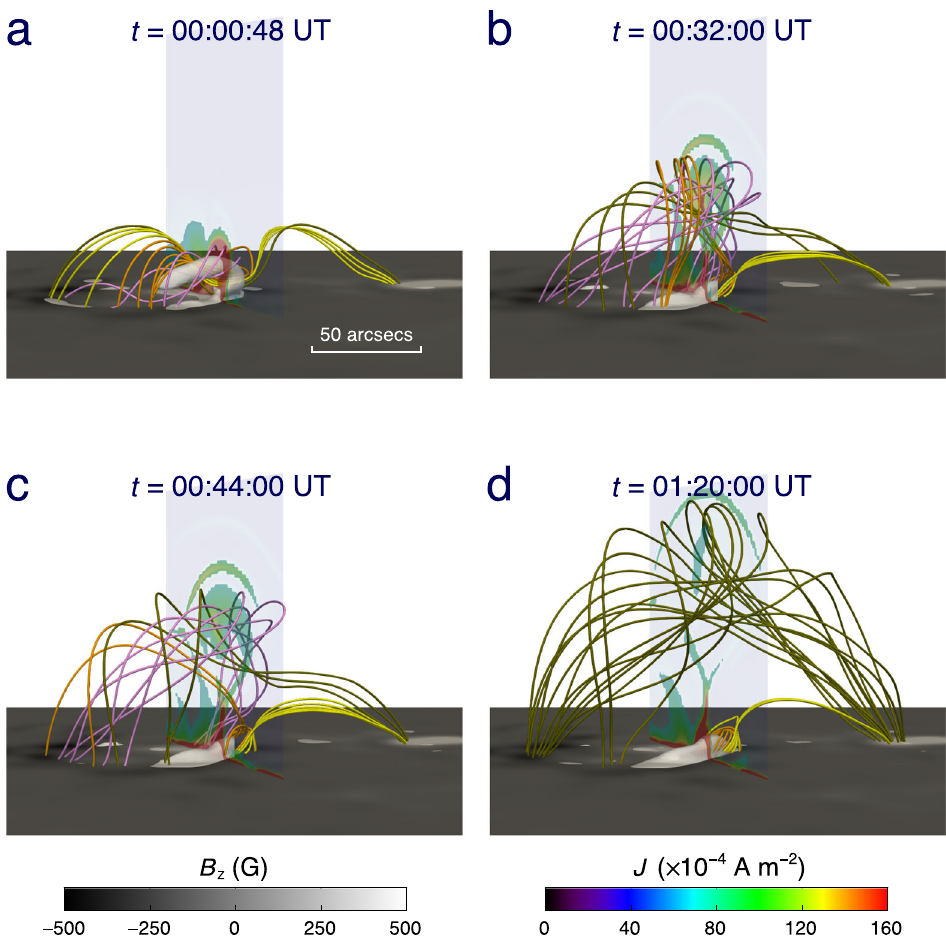
Fig. 4 Snapshots showing the MFR and the electric current density. a – d Four snapshots at 00:00, 00:32, 00:44, and 01:20 UT on 30 January 2015 corresponding to the pre- fl are, fl are onset, fl are peak and end times, respectively. The yellow and orange lines have the same meaning as that in Fig. 2b. The pink and olive lines within the MFR represent the fi eld lines connecting the negative polarity N1 and the positive polarities P1 and P2, respectively. The vertical transparent slice displays the electric current density. The white semi-transparent isosurface represents the electric current density larger than 32.9% of the maximum value in the whole domain. The background shows the distribution of the vertical magnetic fi eld component, B z